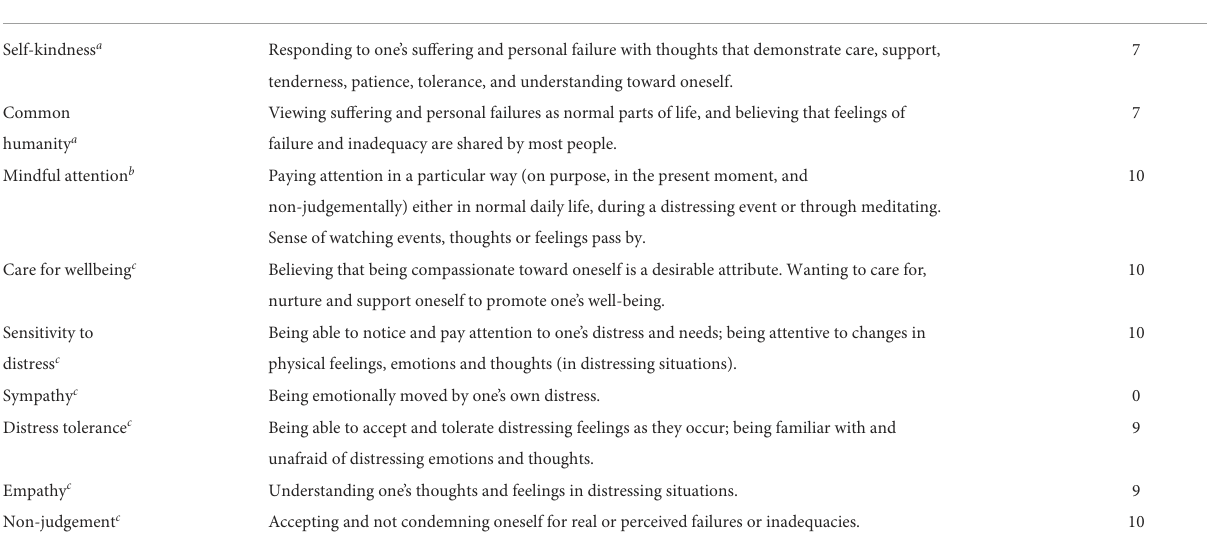
TABLE 2 Compassion-related a priori codes used in the template